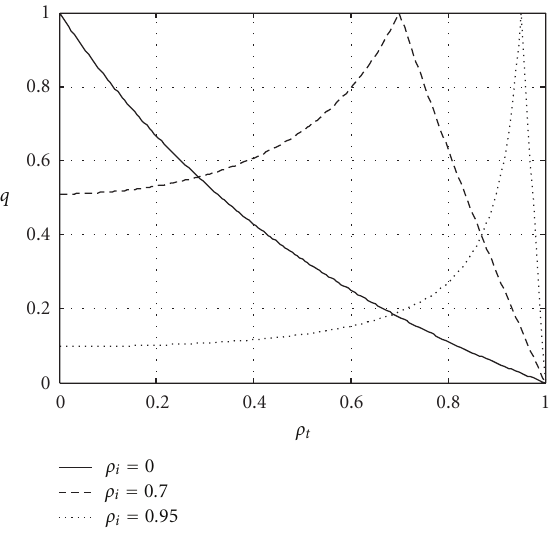
Figure 4: Proportion of remaining samples as a function of target correlation coe ffi cient ρ t , for three di ff erent values of initial correlation coe ffi cient ρ i .